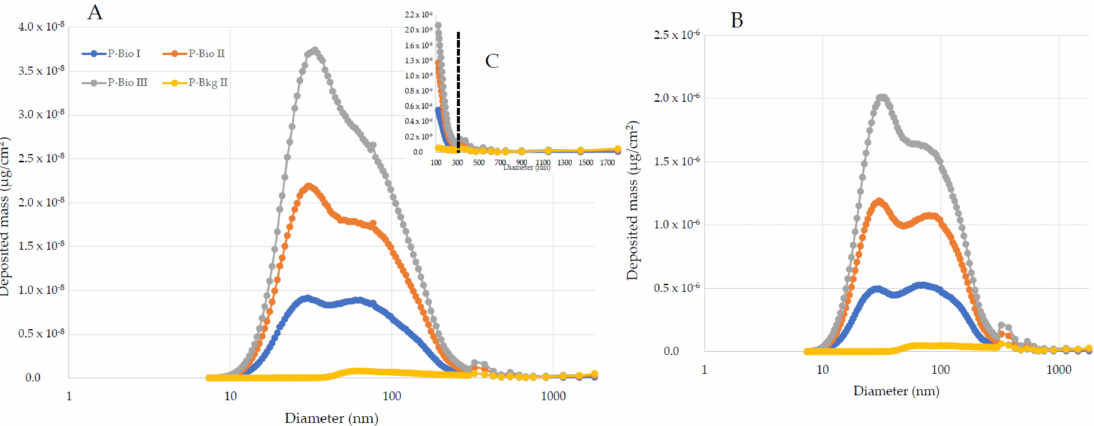
Figure 4. Pulmonary deposition of biofuel blends emitted (P-Bio I to III), and the background (P-Bkg II) particles for the pulmonary ( A ) and trachea–bronchial ( B ) regions. Maximal contribution of emission is within 300 nm ( C ), after which background particulate distribution accounts for the measured deposition. Two peaks of deposition are reported, one at 30 nm and one at around 80 nm.